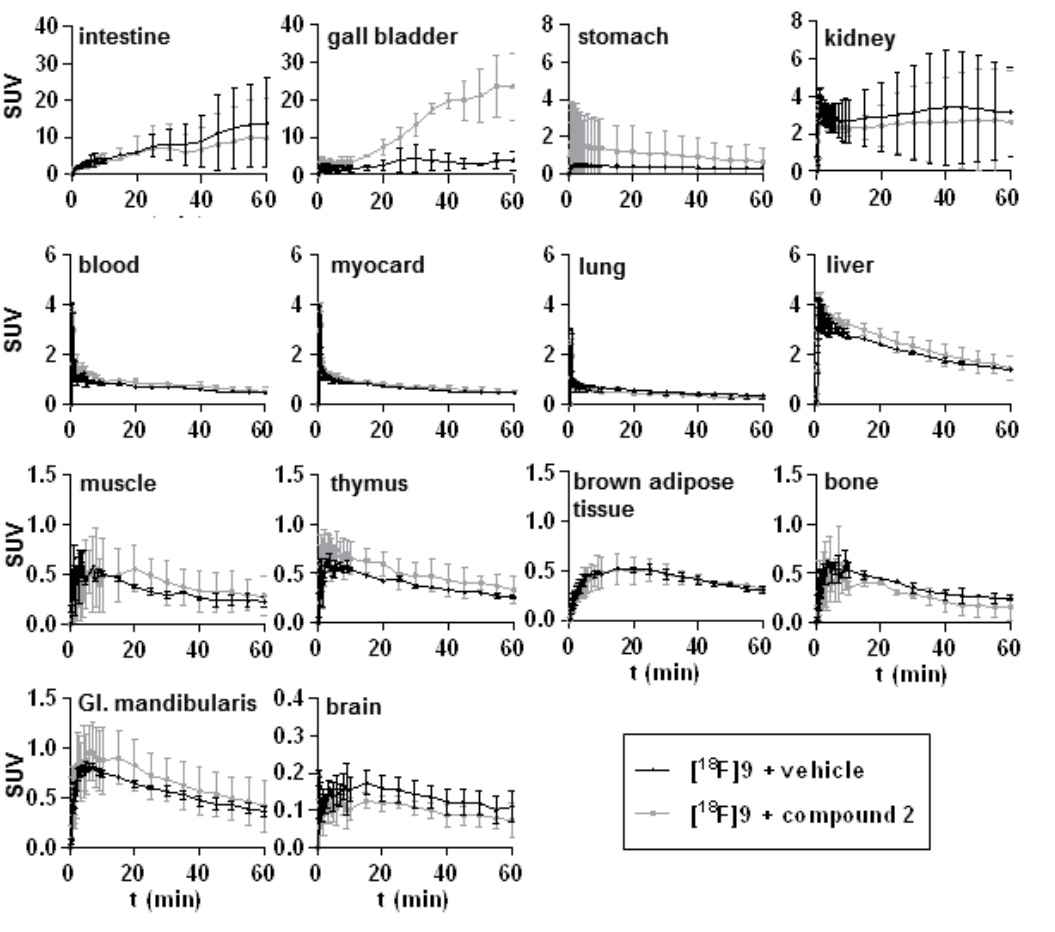
Figure 3. Biodistribution of [ 18 F]9 in female CD-1 mice derived by small-animal PET over 60 min; time–activity curves (TACs) for tissue uptake are expressed as standard uptake values (SUVs), n = 2, mean ± SD.